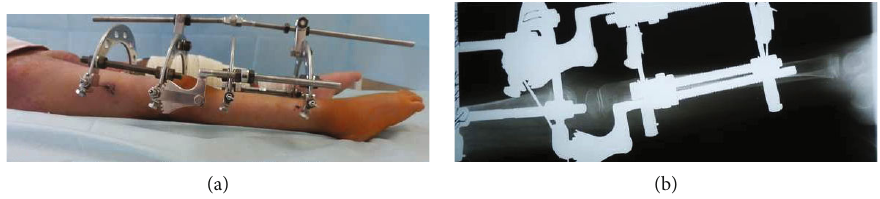
Figure 3: (a, b) Correction of knee joint deformation was achieved (a). Full extension of the knees has been achieved. Note that the lateral radiograph showed the full correction of the knee contractures (b).